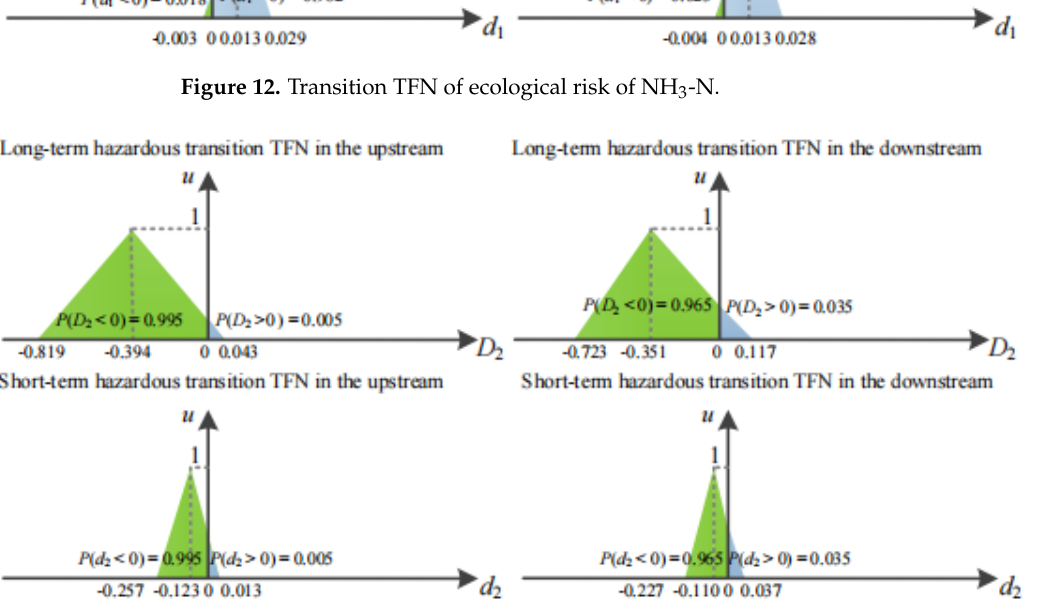
Figure 13. Transition TFN of ecological risk of Cu.